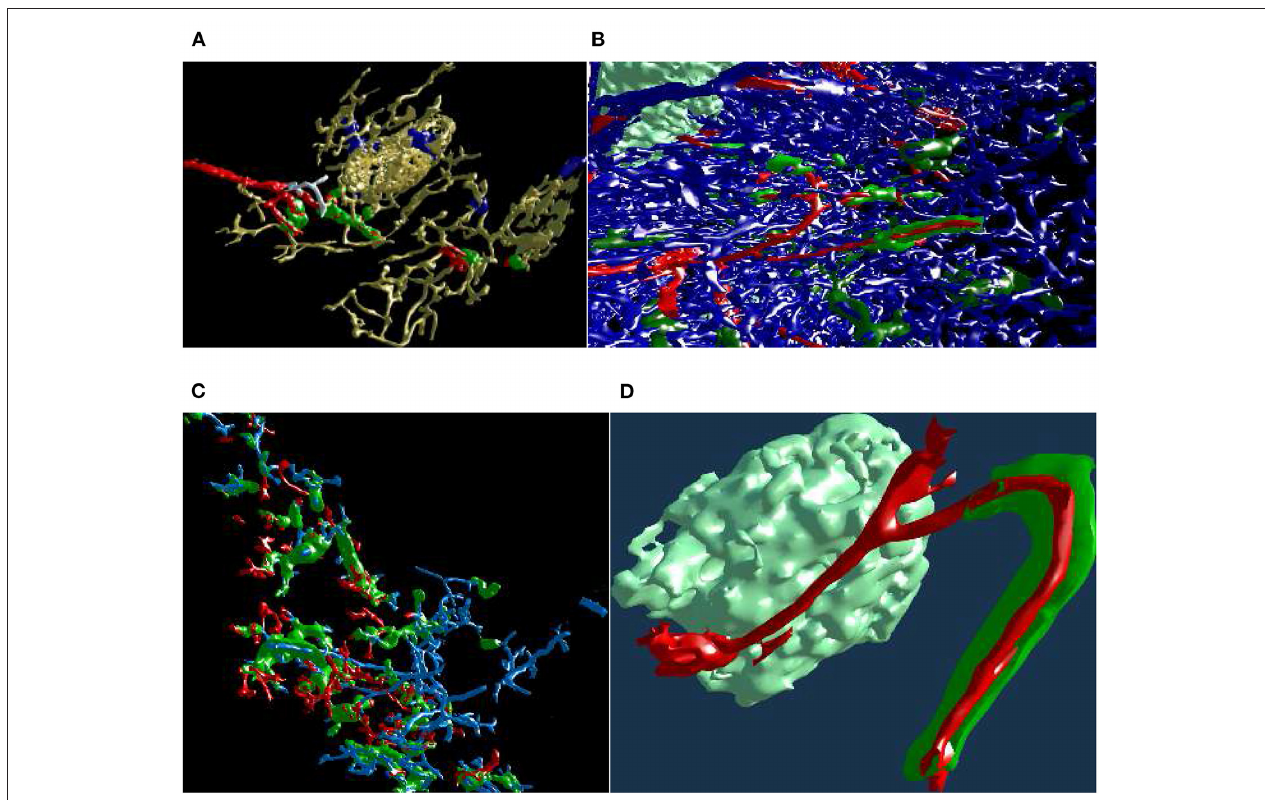
FIGURE 13 | Mesh annotation and painting. (A) “Red pulp” data set, final result (Steiniger et al., 2018b). Blood vessels and some support structures are yellow. While some capillaries are red, some other capillaries (white), while coming from the same arteriole (also red), do not have a sheath at all. The sheaths are either green or blue, depending on the connections of their capillaries. A similar, but different image appeared in Steiniger et al. (2018b) under CC-BY 4.0 license. (B,C) The natural complexity of the “sheaths alternating” data set ( Steiniger et al., 2021) is very high. With mesh annotation, painting, and removal of irrelevant details we were able to keep the complexity at a tolerable level. (B) An arteriole (red) is entering from left, transitioning into capillaries (still red), a capillary sheath (green) is is cut open, showing the capillary inside. Other capillaries are blue. (C) This figure shows a single system, starting with an arteriole. Front plane clipping opens the capillary sheath. (D) Final result of mesh annotation, painting, and removal of irrelevant details. The complexity is now greatly reduced. The meshes are cut open by the front clipping plane. An arteriole (red) is entering from left in the proximity of a follicle, this arteriole is splitting up into capillaries (still red). Those enter capillary sheaths, one is shown (in green), curving around the follicle. This sheath is cut open, showing the capillary inside. Similar, but different figures can be found in Steiniger et al. (2021).